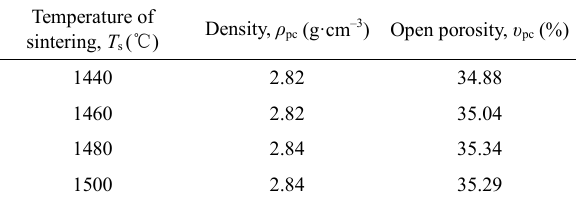
Table 1 Density and open porosity of porous ceramics Temperature of